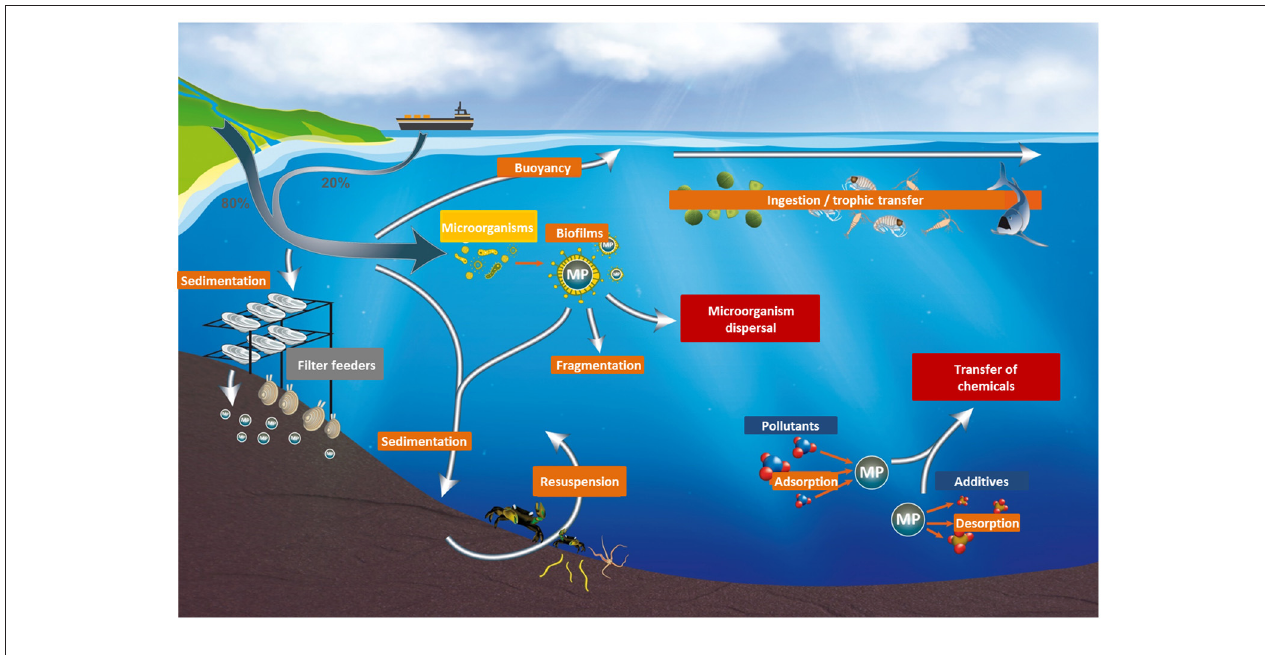
FIGURE 1 | Fate of microplastics in the marine environment.